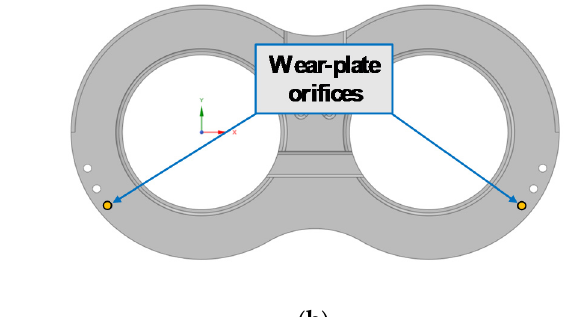
Energies 2021 , 14 , x FOR PEER REVIEW